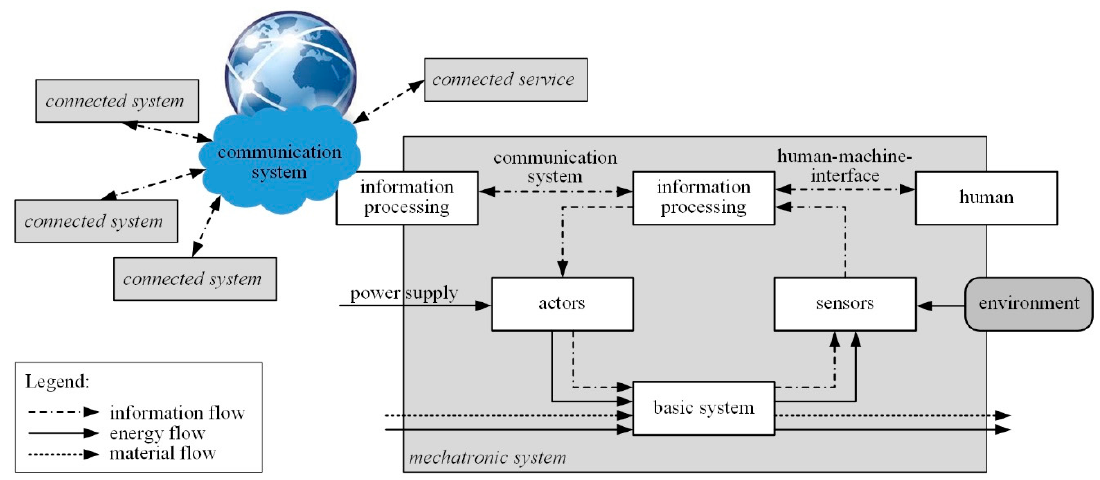
Figure 1. Structure of a mechatronic system and a CPPS.